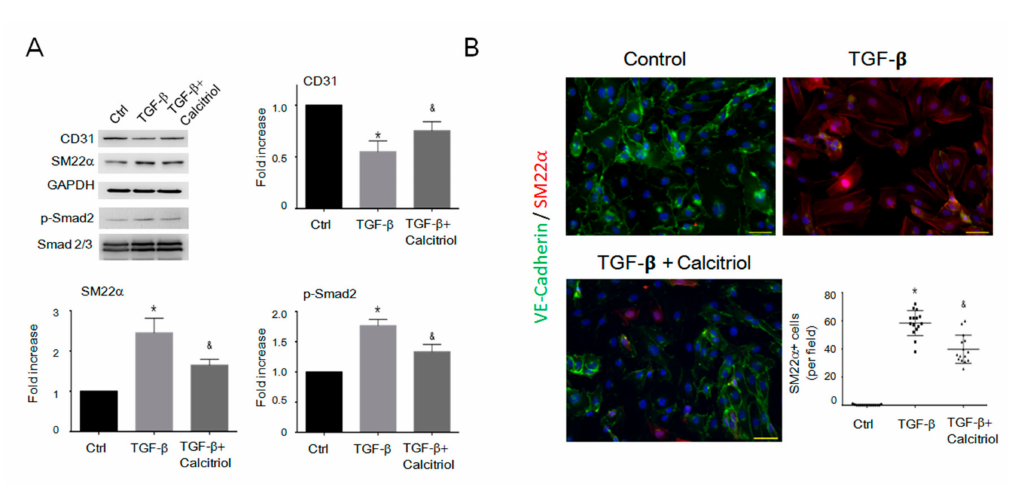
Figure 6. Calcitriol-attenuated TGF- β -induced EndMT in vitro. ( A ) Representative immunoblotting analyses of CD31, smooth muscle 22alpha, and p-Smad2 in the human umbilical vein cells (HUVECs). Quantification of the relative protein levels (n = 3). GAPDH was used as an internal control, and total Smad2asaninternalcontrolforp-Smad2. Dataareexpressedasmean ± SEM.* p < 0.05vs. Ctrl, & p < 0.05 vs. TGF- β . Experiments were conducted in triplicate. ( B ) Representative photomicrographs of double immunofluorescence staining antibodies with SM22 α (red) and VE-cadherin (green). Quantification of vimentin + cells per visual field in the Ctrl, TGF- β .only, and TGF- β –calcitriol groups. Experiments were conducted in triplicate (5 high power fields (HPFs) per mouse, 15 HPFs total). Scale bar: 200 µ m